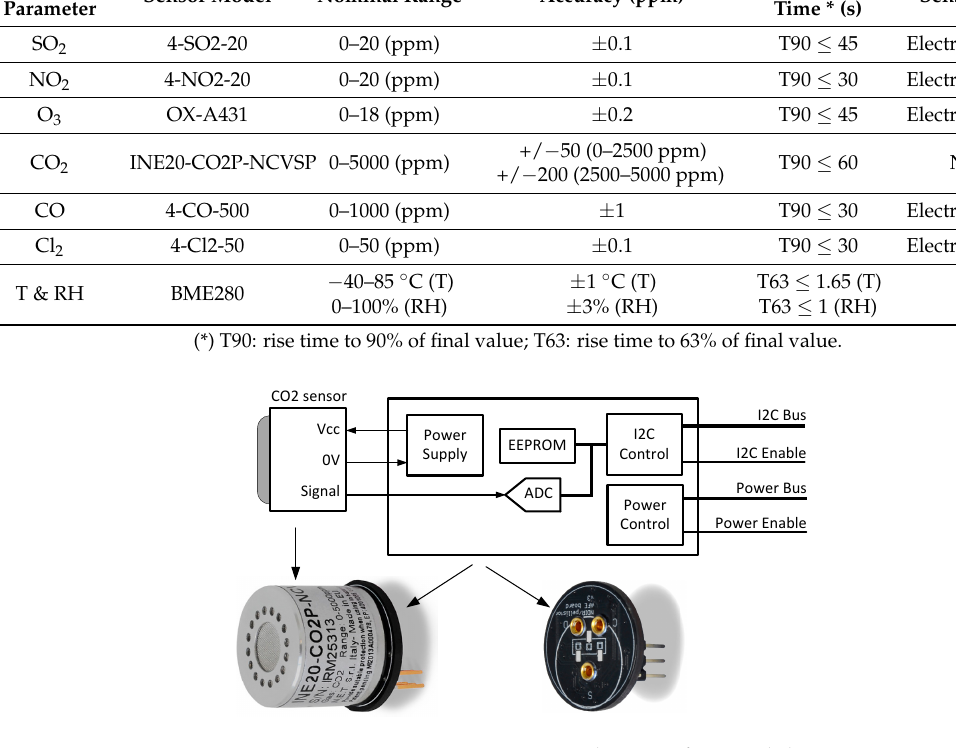
Figure 4. Block diagrams of the interface modules for the: three-electrode ( a ); and four-electrode ( b ) electrochemical sensors. The wireless sensor node has to incorporate a suitable module to communicate with the gateway. Sensor nodes deployed inside buildings send data to a gateway with single hop or multi-hop communication modes; the former mode has been chosen in the present work. Power requirement, distance and indoor through-wall communication [16] were the main factors considered when choosing the XBee PRO S2 radio module for the IAQM system. The Waspmote board is fitted with a socket compatible with the chosen XBee PRO S2 radio module, and the gateway described below is also readily compatible with the same module. 2.1.2. Gateway The core of the gateway (Figure 5) is the flexible Raspberry Pi2 model B minicomputer with the following relevant features: •